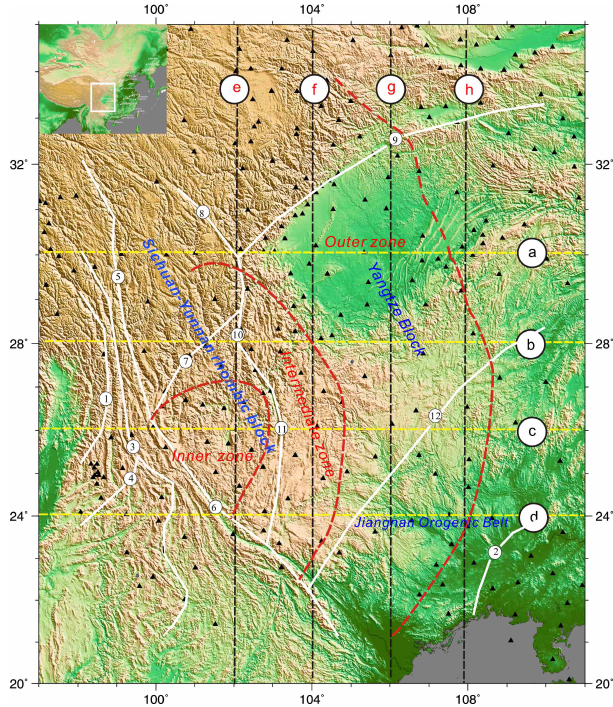
Figure 1. Tectonic framework, distribution of seismic stations (black triangle) and the east–west and north–south profiles in